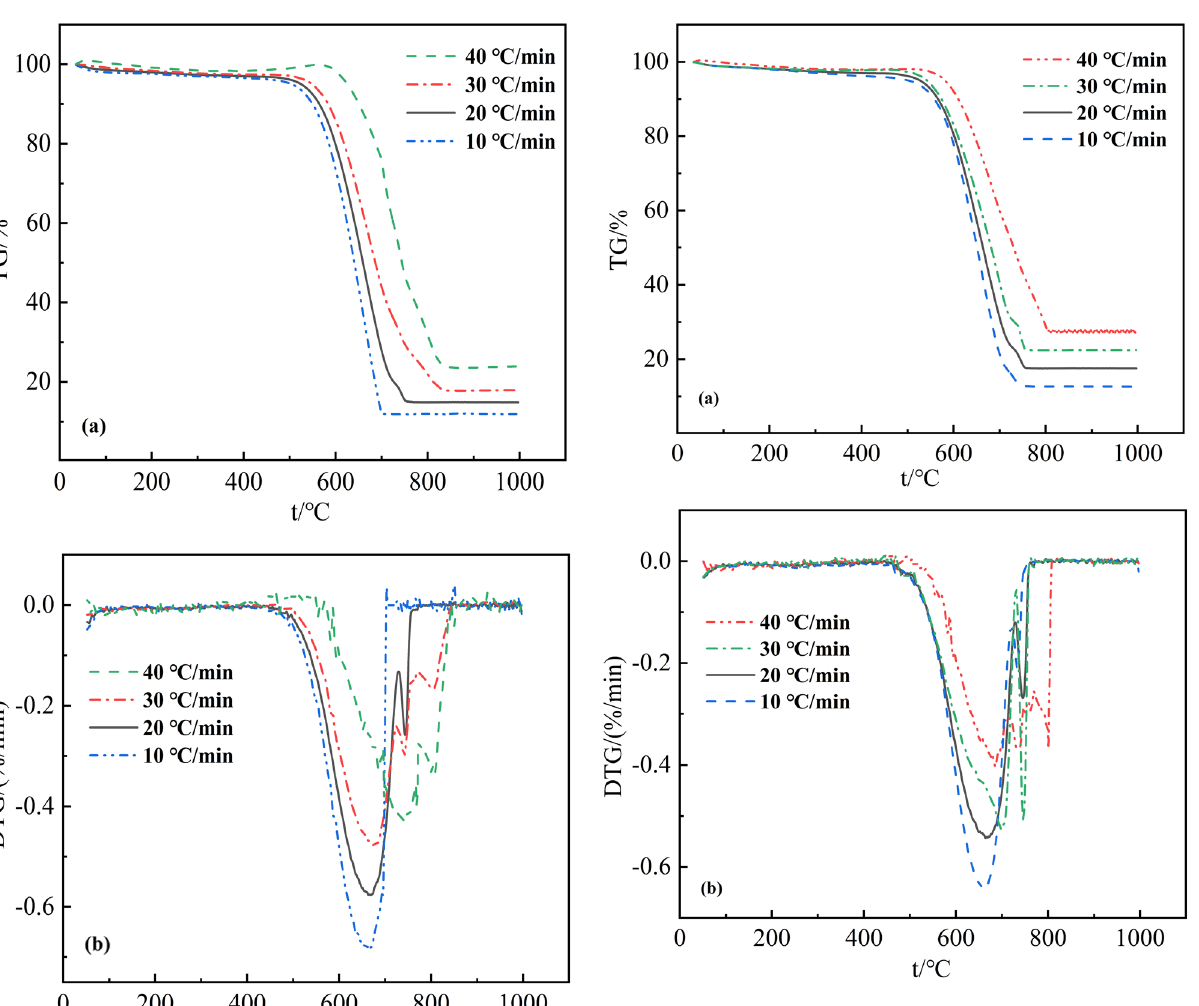
Figure 6: TG – DTG curves of K5 sample at di ff erent heating rates: ( a ) TG and ( b ) DTG